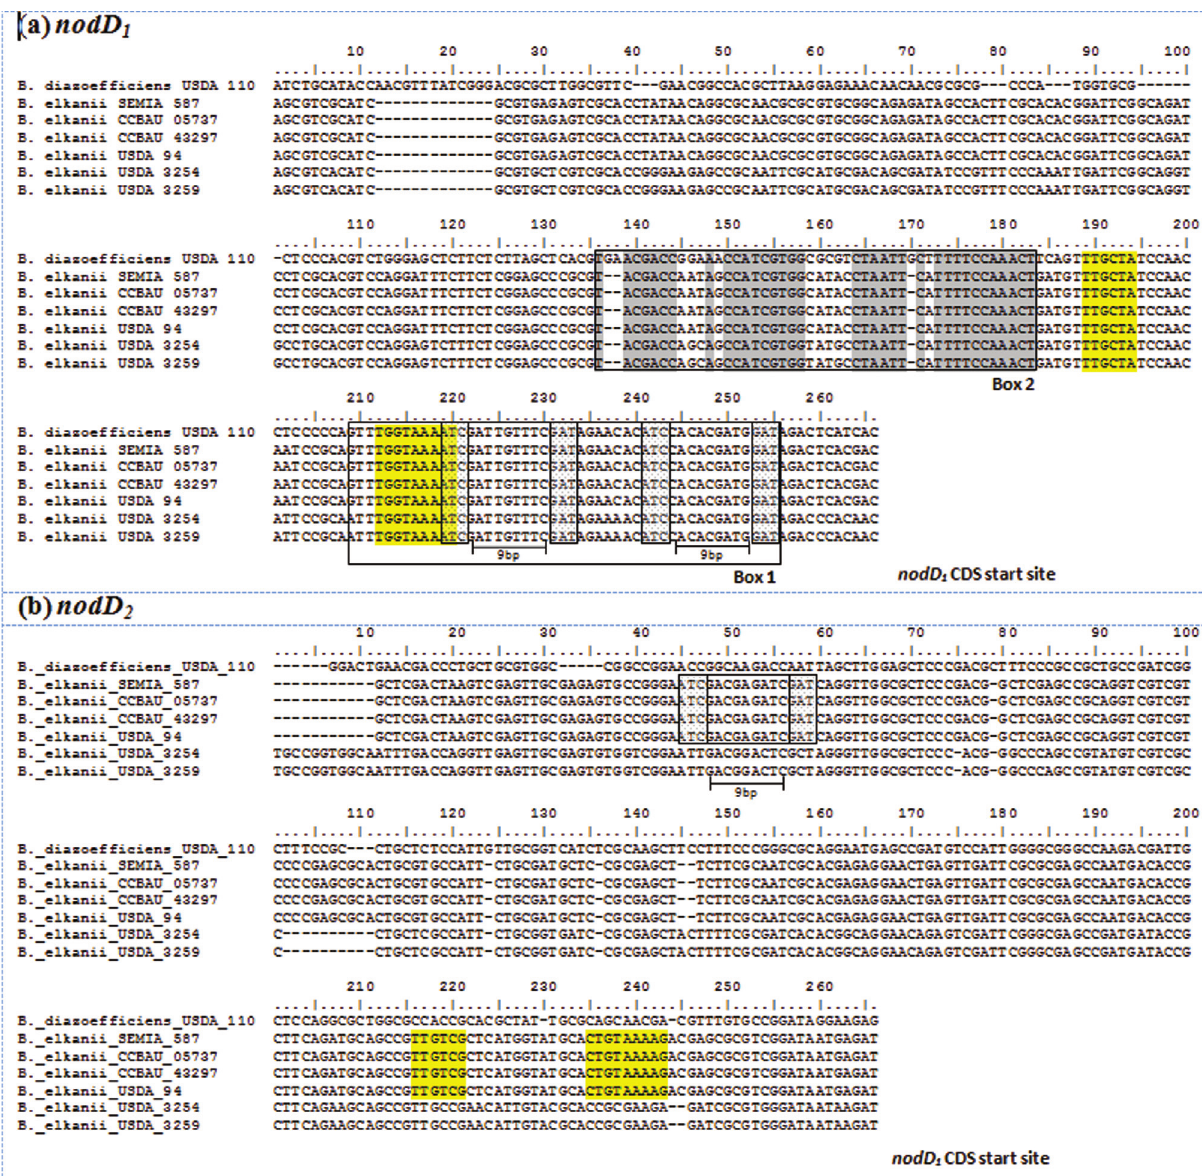
Figure 2 - Alignment of the ~250-bp region upstream from nodD ORFs in Bradyrhizobium genomes. (a) The nodD 1 nod box sequences are boxed and show a consensus nod box sequence near the nodD 1 ORF start codon (Box 1) and a presumptive nod box-like sequence (Box 2) upstream, with conserved residues highlighted in grey, and (b) nodD 2 partial nod box sequence structure (boxed) found in some B. elkanii genomes. Smaller boxes denote the puta- tive nod box motifs (ATC-N 9 -GAT) with their respective palindromic structure. Yellow shaded sequences show a -10/-35 (cid:22) 70 potential promoter. Se- quences read 5’ to 3’ from right to left, with the first nucleotide in the sequence representing that immediately prior to ATG from the nodD 1 (a) or nodD 2 (b) CDS start